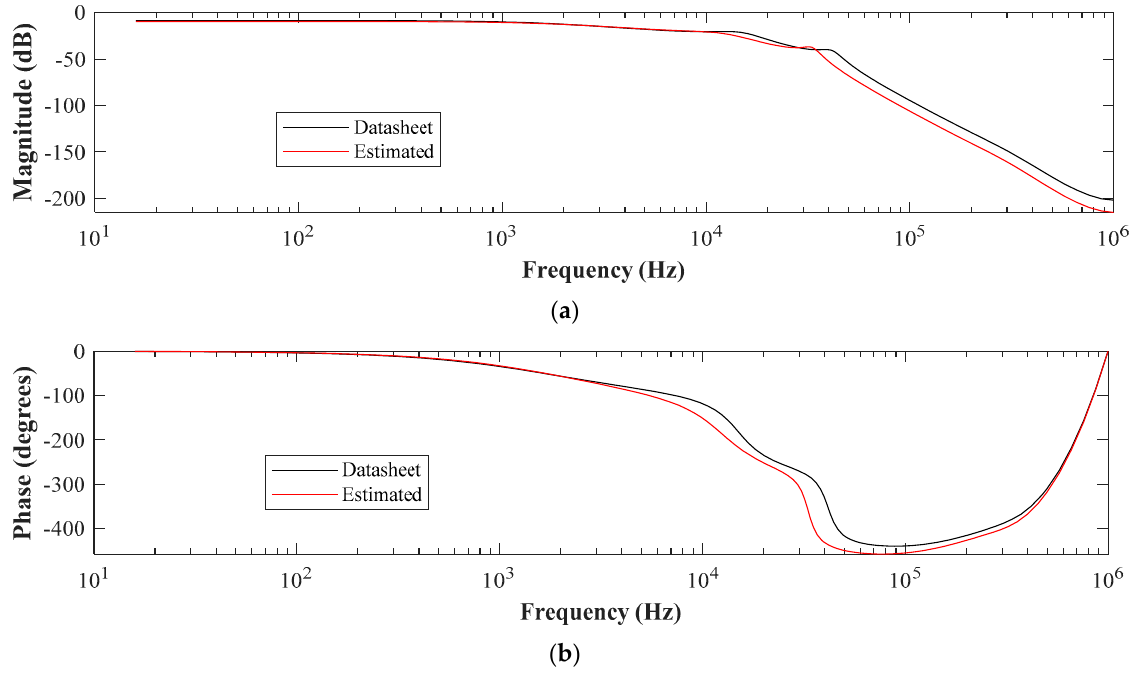
Figure 12. Comparison of the actual and the estimated bode plots of the EMI filter: ( a ) magnitude; ( b ) phase.